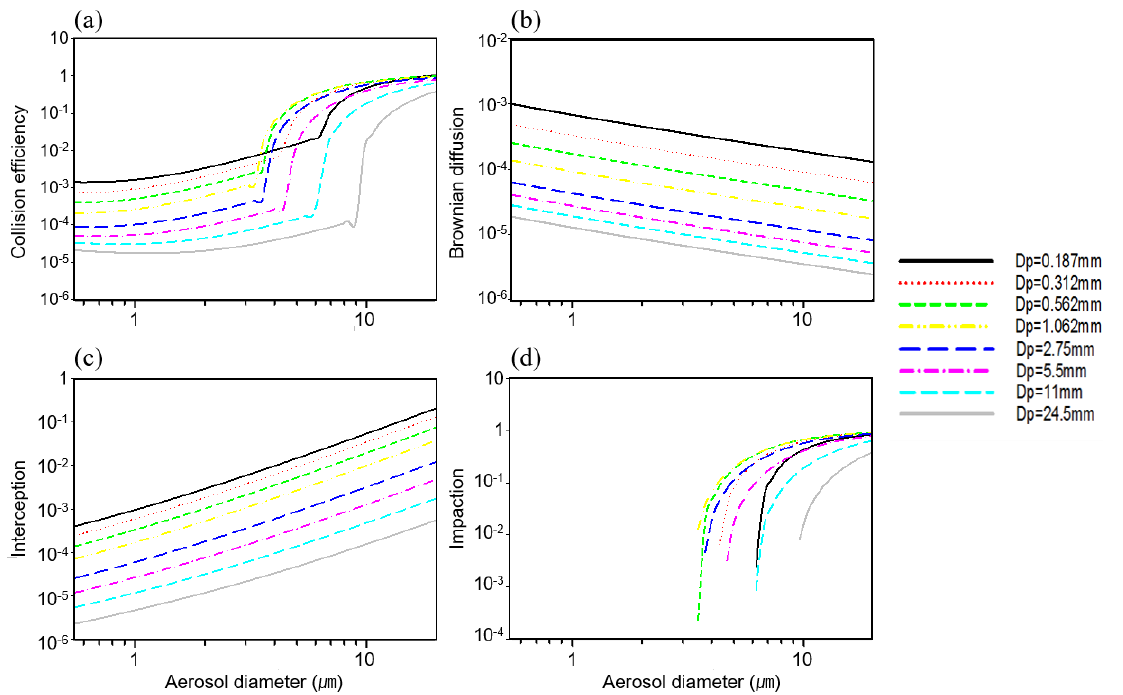
Figure 5. Variation of ( a ) collision efficiency, ( b ) Brownian diffusion, ( c ) interception, and ( d ) im- paction versus aerosol diameter for several raindrops.